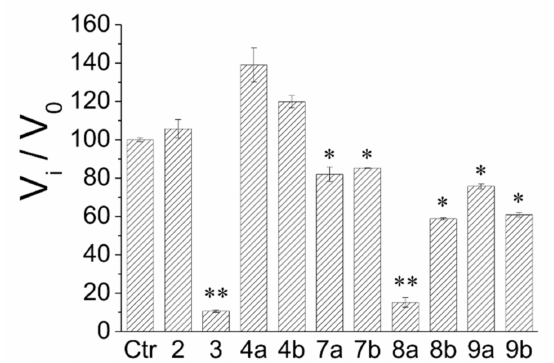
Figure 2. Preliminary screening assay on PTP1B. All assays were started by diluting an aliquot of PTP1B in the assay solution containing substrate alone (control test) or substrate and an aliquot of each compound (20 µ M, final concentration). After 30 min, the reactions were stopped by adding a concentrated KOH solution. The enzyme activity was determined by measuring the amount of p-nitrophenol that was released in each sample using a spectrophotometer. Data obtained were normalized respect to control sample. Data showed in the figure represent the mean value ± SD ( n = 3). Statistical analysis was carried out using one way ANOVA followed by Tukey’s HSD test for pairwise comparisons. Statistics have been drawn on raw data and compare samples to control (Ctr). * p < 0.05; ** p < 0.01.